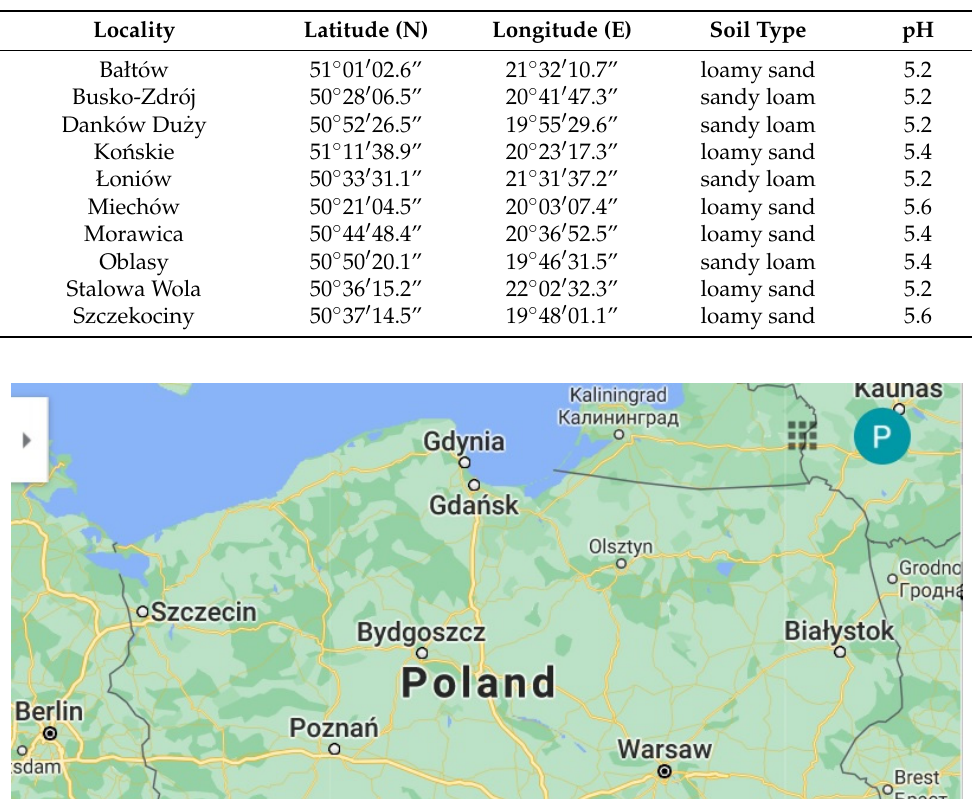
Table A1. Characteristics of soil samples tested for entomopathogenic nematodes.